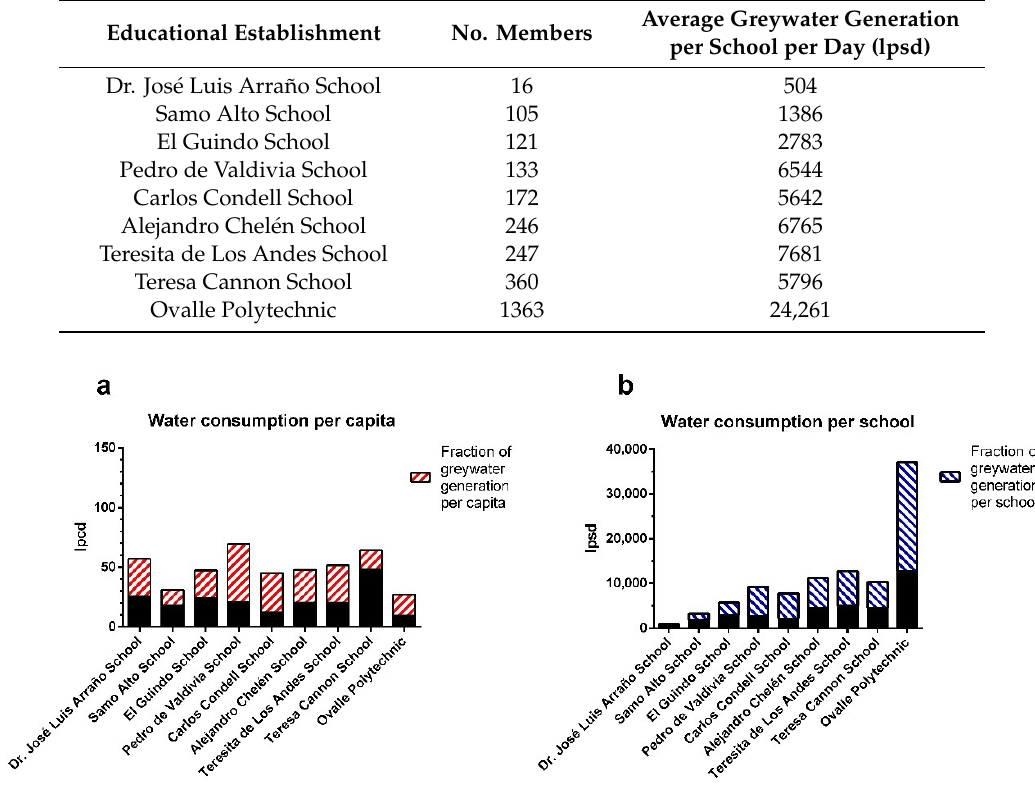
Figure 3. Total water consumed daily ( a ) per capita and ( b ) per school. The columns represent the total water consumption and the hatched area corresponds to the fraction of the total water consumption that becomes greywater.